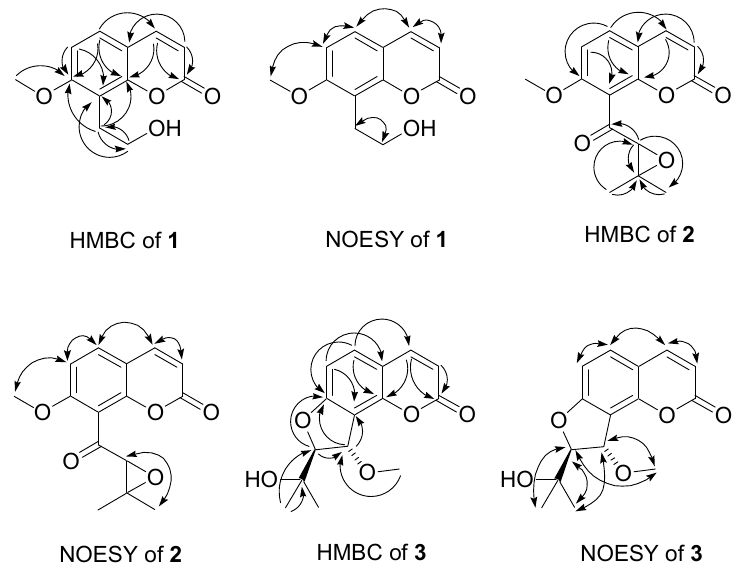
O -induced oxidative stress on Neuro-2a neuroblastoma 2 2 O treatment. Values are 2 2 O treatment. The symbol (#) 2 2